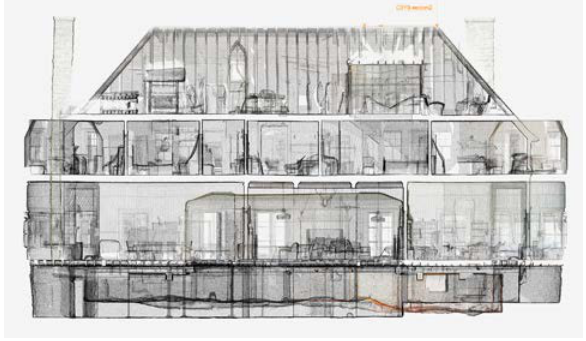
Fig.5 – Section through the pointcloud for drawing in Autocad 2.9 Record photography to compile a complete portfolio of the house